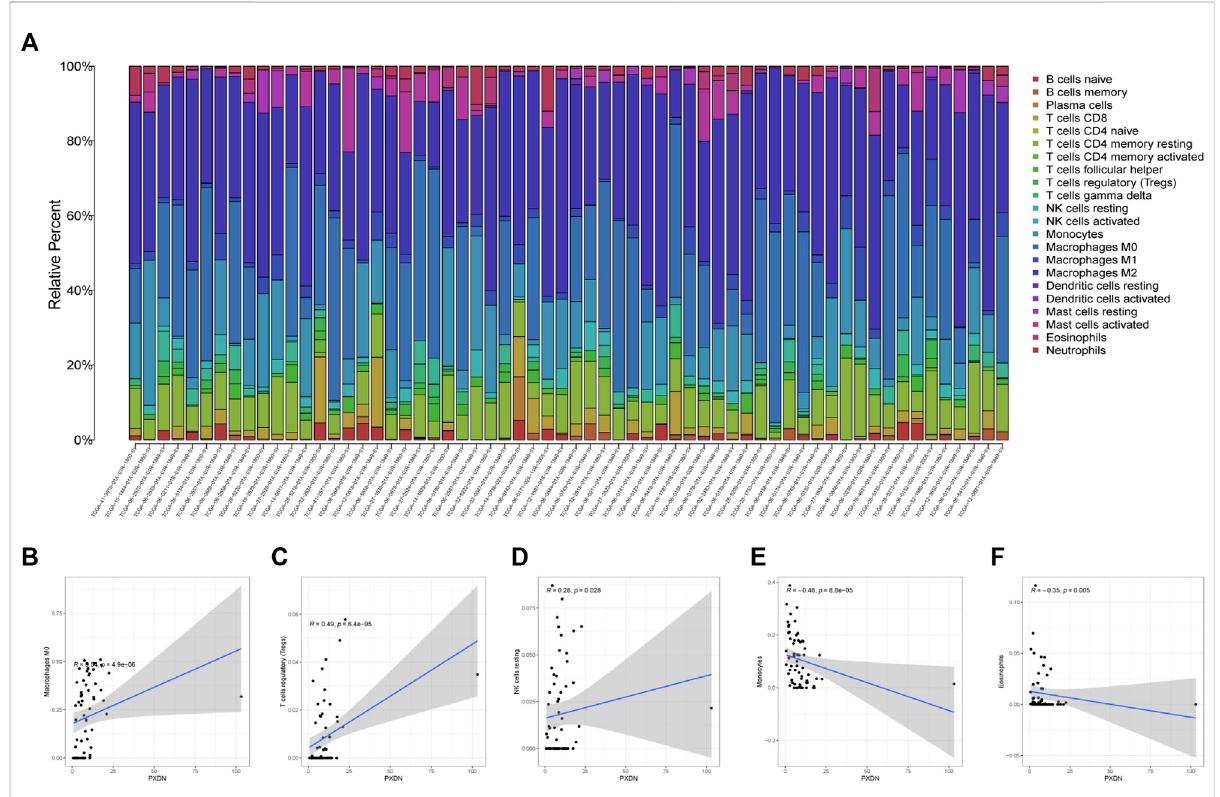
assessed the effect of silencing PXDN on GBM cell migration. Signi fi cantly, loss of PXDN decreased the migration of GBM cells (Figure